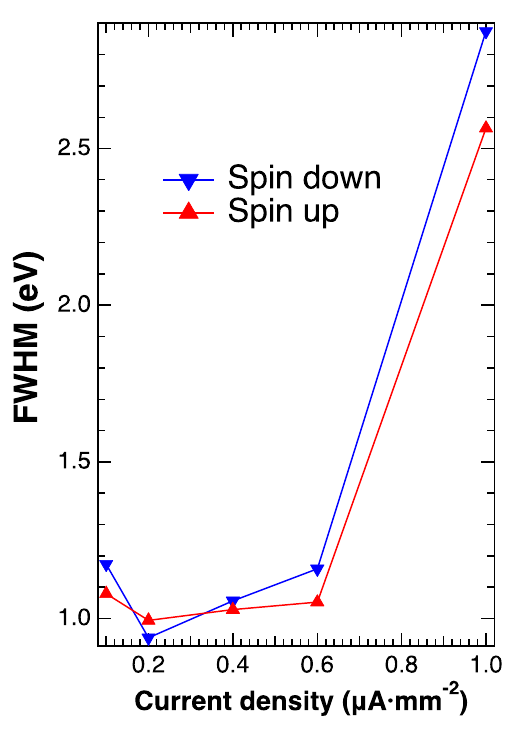
Fig. 4. FWHM of the SPIPES spectra of Au(111) sp -bulk state ( q = 46°) as a function of the current density over the